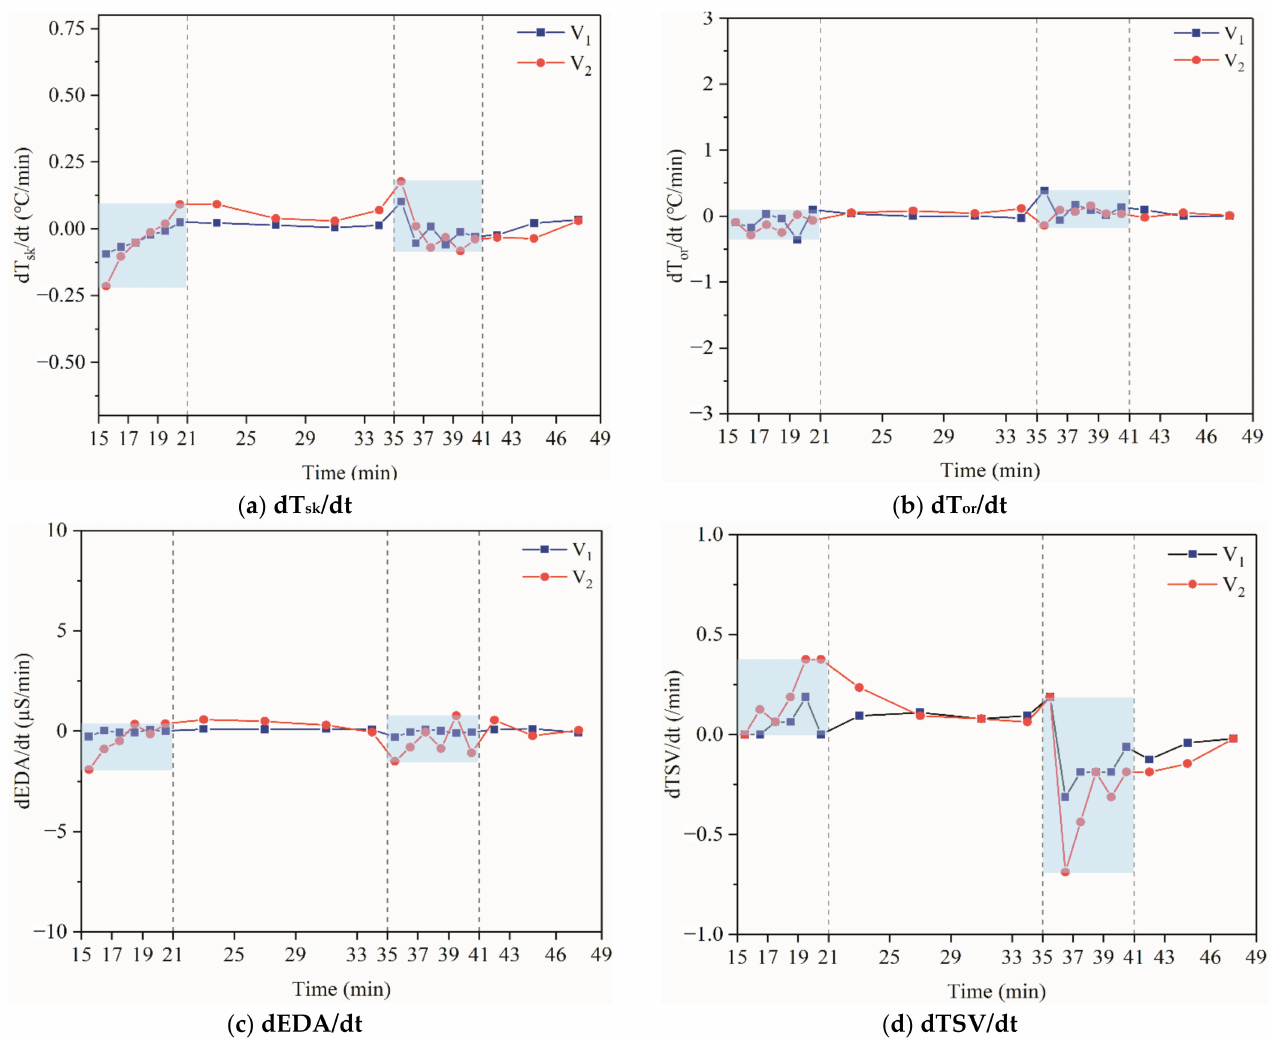
Figure 12. The rate of change of physiological parameters and